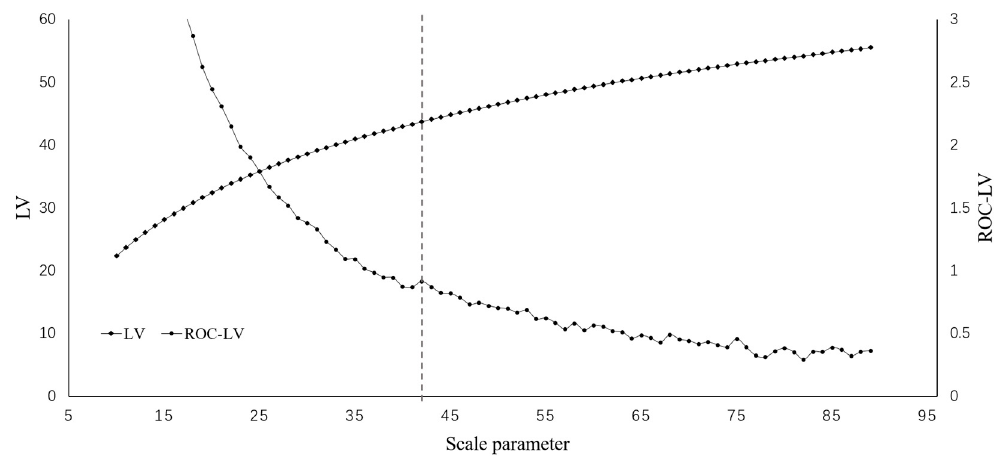
Figure 5. Local variance (LV) and rates of change of LV (ROC-LV) values against corresponding scale parameters (SPs) produced by the Estimation of Scale Parameter 2 (ESP 2) tool. The gray vertical dotted line indicates the optimal SP.